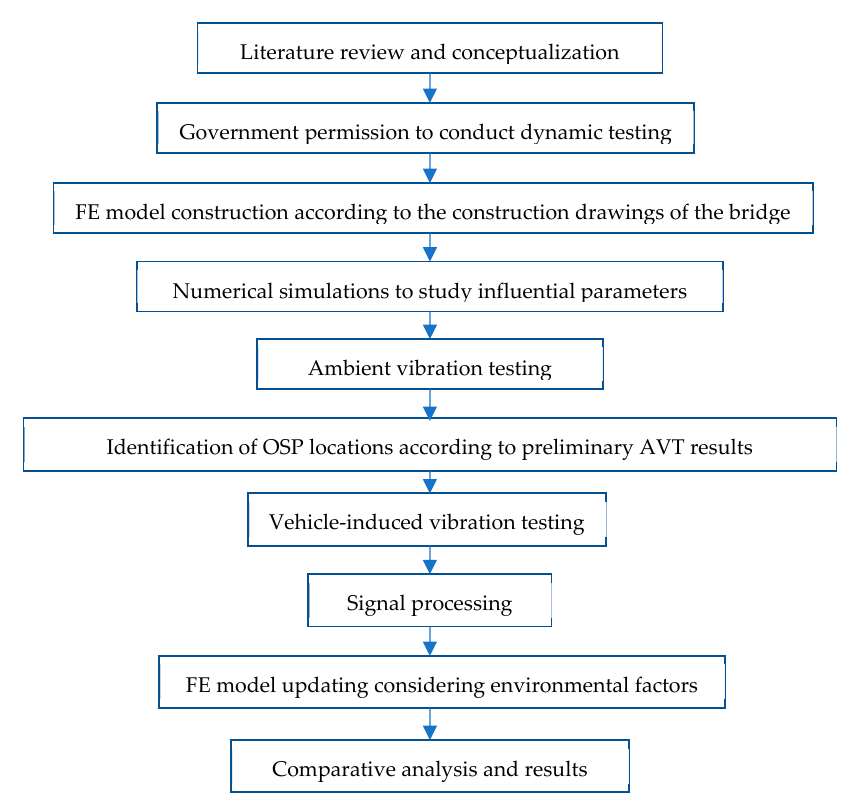
Figure 4. Schematic flow chart showing field study.